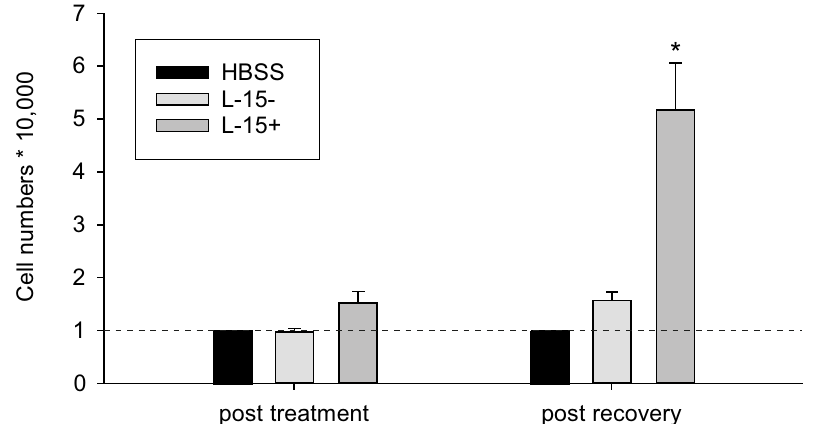
Figure 1. Cell density assay (Hoechst 33342) with Z3 zebrafish cells in control experiments using different culture media. Cell numbers were measured once after the 18 h treatment and once after the 6 h recovery period. L-15 − : L-15 complete media without FBS L-15+: L-15 complete media. Cell numbers were normalized to 10,000 cells of the Hank’s buffered salt solution (HBSS) control. Statistical analysis was performed prior to data normalization using a t -test. Groups were compared to HBSS treatment (* p ≤ 0.05). Values are mean ± standard error from 3 biological replicates.